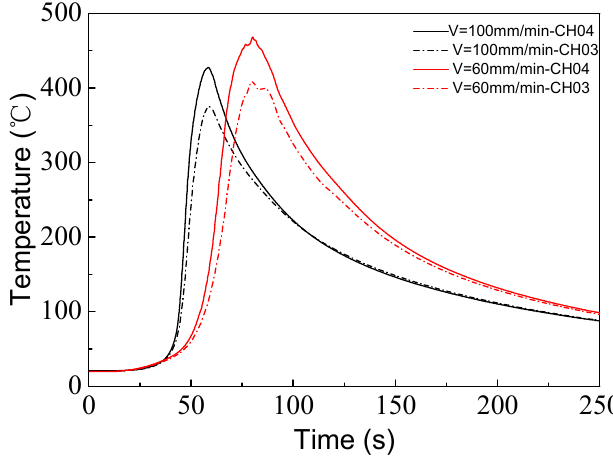
Figure 7. Temperature measurements at CH03 and CH04.